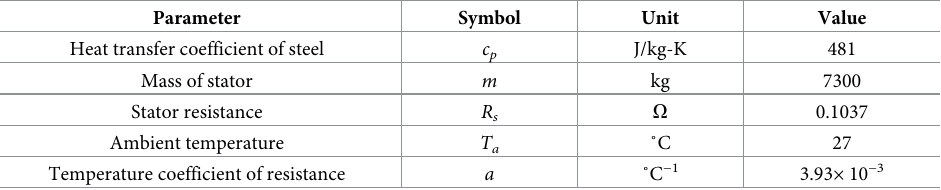
Table 2. Parameter assumption for thermal model